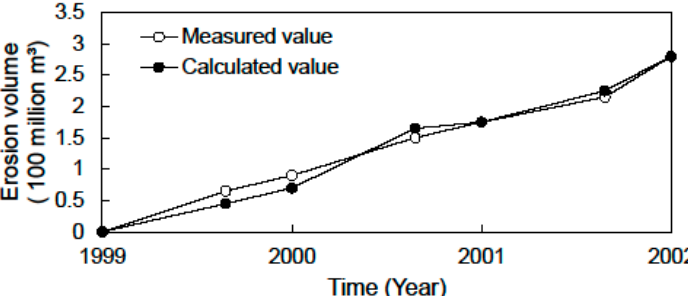
Figure 8. Verification results of the erosion volume after the flood season from 1999 to 2002.